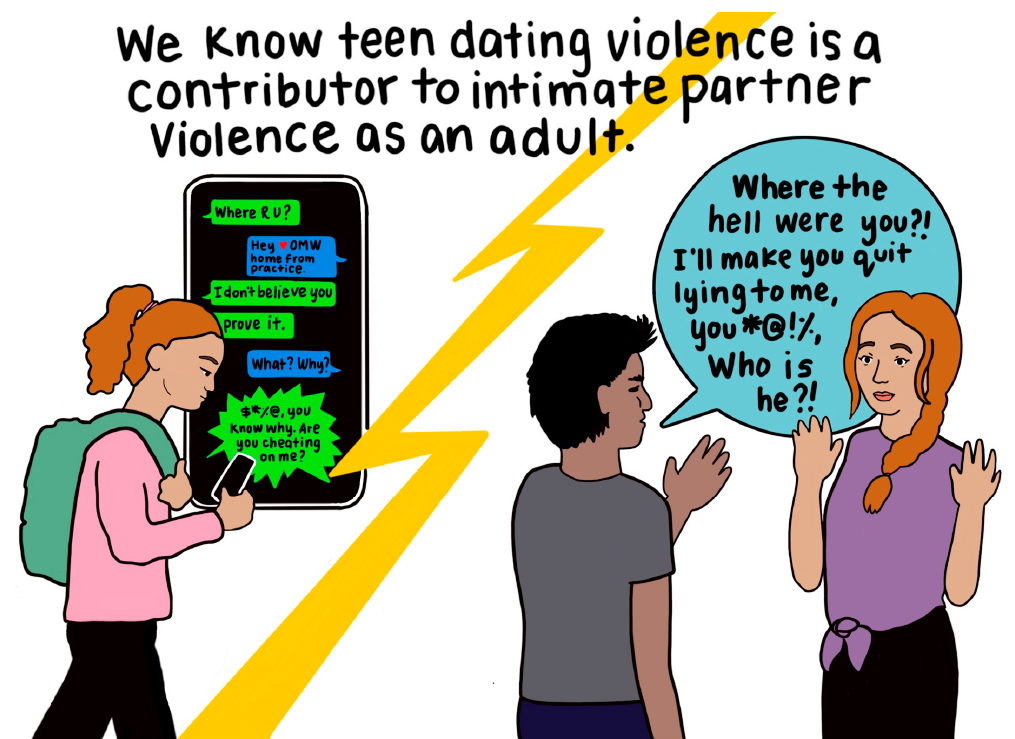
Figure 2. A teenager is texting and the conversation indicates emotional and verbal abuse. Then there is an image of the woman as an adult in another abusive relationship. See I.D. 2 in Appendix A.